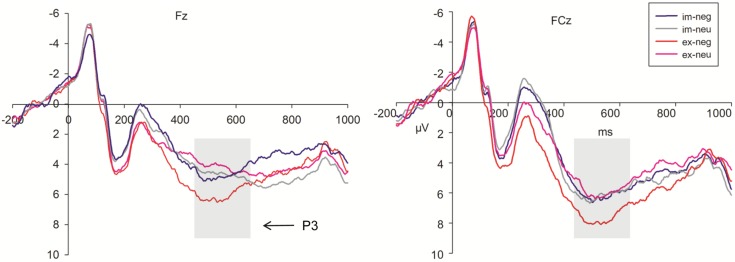
Grand averages evoked by negative and neutral stimuli under implicit task (blue lines; gray lines) and explicit task (red lines; pink lines) in No-go trials at Fz, FCz sites (im, implicit; ex, explicit; neg, negative; neu, neutral).